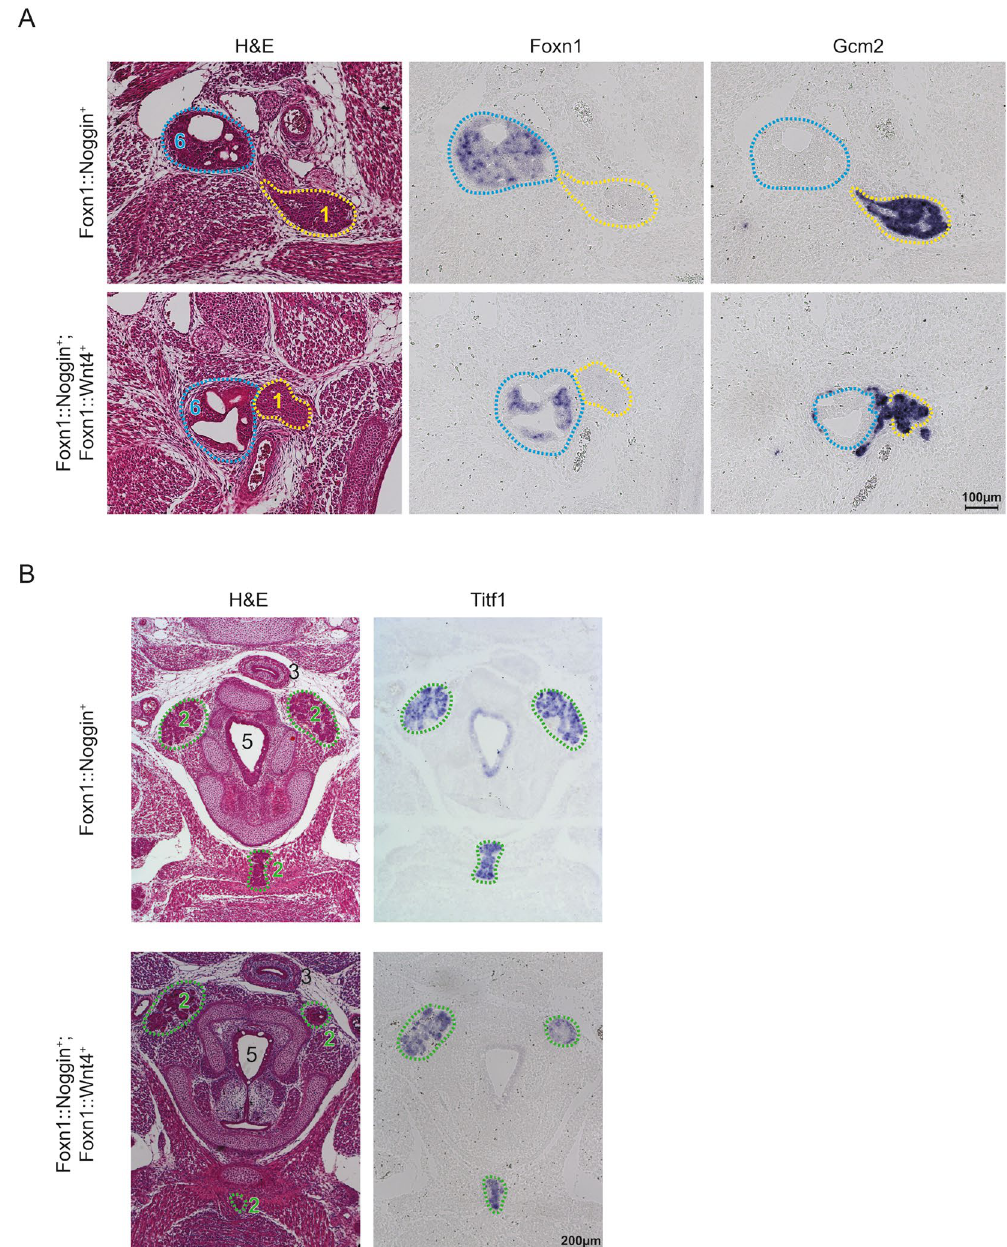
Figure 7. Combining BMP-inhibition with Wnt4-overexpression exaggerates organ migration defects. ( A ) Development of thymus and parathyroid in E15.5 Foxn1::Noggin -transgenic (top rows) or Foxn1::Noggin;Foxn1::Wnt4- double transgenic embryos (bottom rows) analysed as in Fig. 5A. ( B ) Development of the thyroid in E15.5 Foxn1::Noggin -transgenic (top rows) or Foxn1::Noggin;Foxn1::Wnt4- double transgenic embryos (bottom rows) as in Fig.